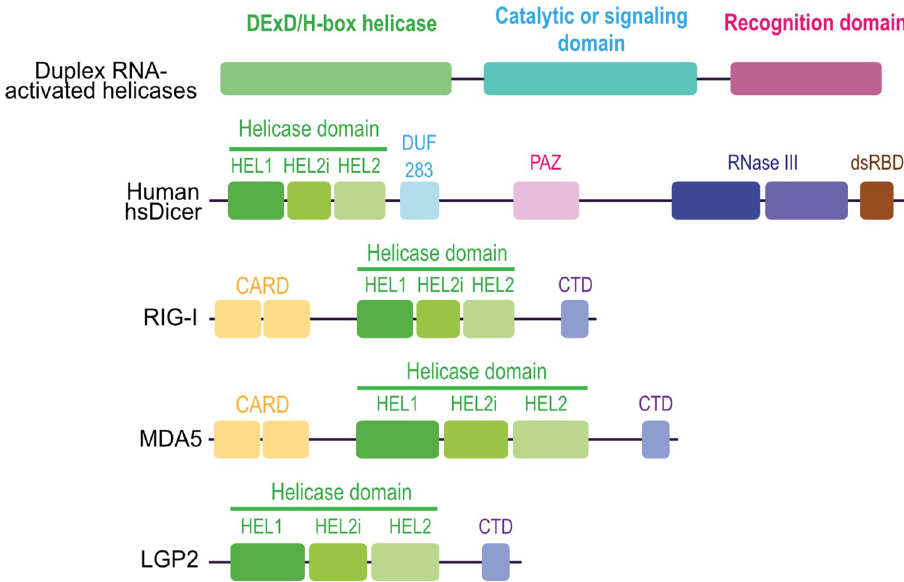
Fig 3. Domains organization of RLRs. RLRs are directly involved in the IFN-I response upon viral infection. RIG-I and MDA5 can activate the mitochondrial adaptor protein MAVS via their N-terminal CARD domains. Their